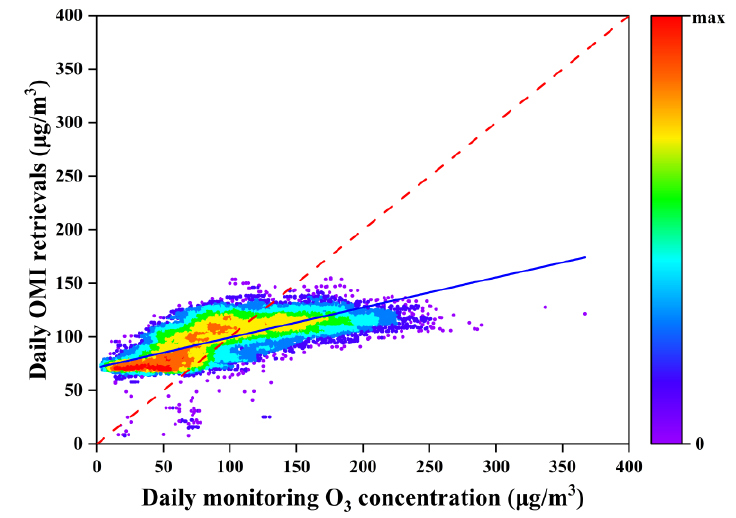
Figure 3. Correlation of daily O 3 concentrations and OMI retrievals. The dashed line is the 1:1 line, while the solid line is the linear regression.